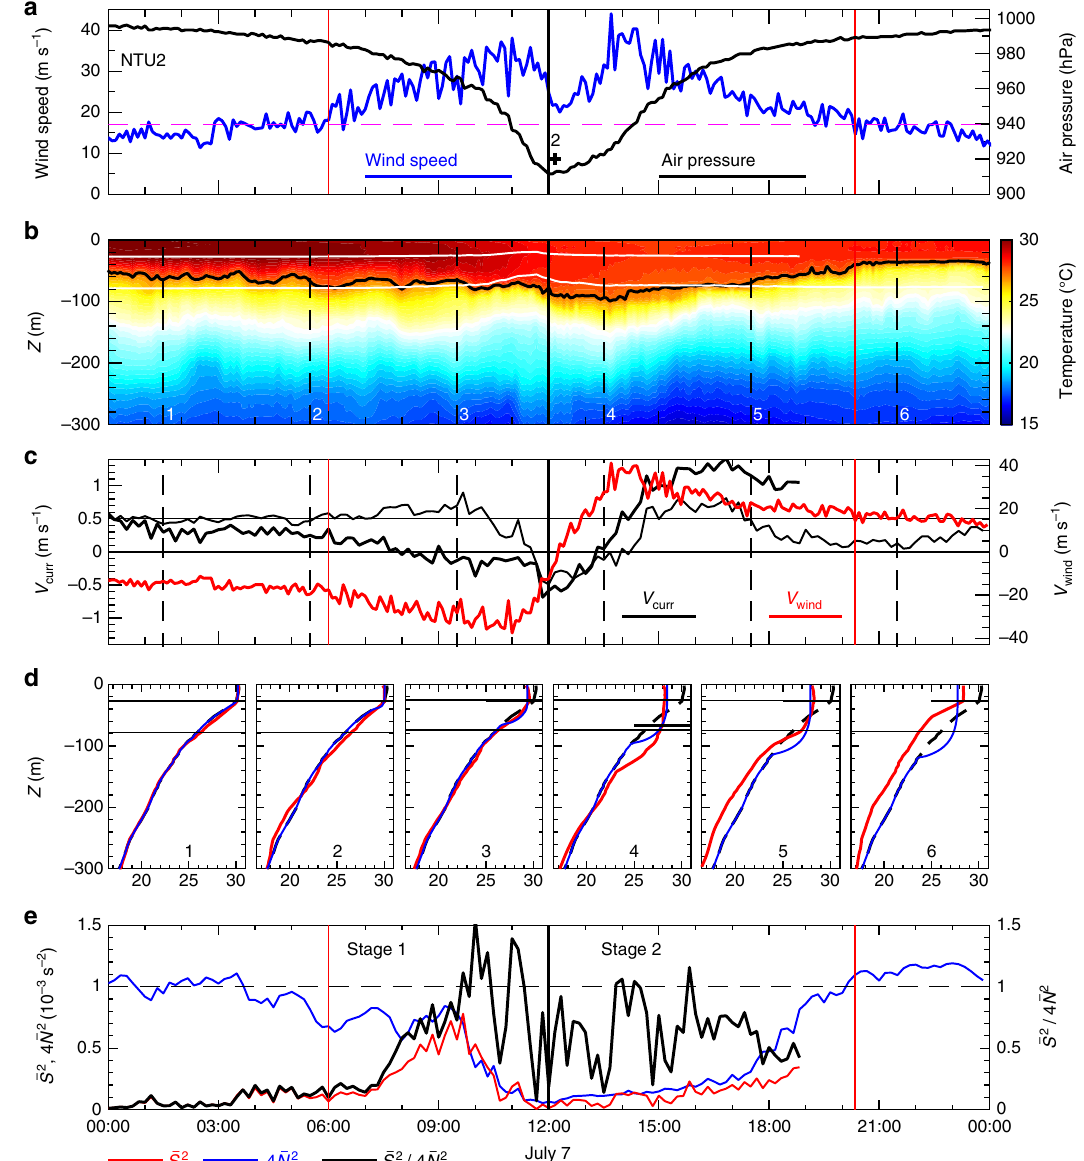
Fig. 2 Buoy NTU2 observations of Nepartak. a Air pressure (black line) and wind speed (blue line); b temperature in the upper 300 m; c meridional current velocity V curr at 25 m (thick black line) and 75 m (thin black line), and meridional wind velocity V wind (red line). The two red vertical lines in a – c mark the beginning (left) and end (right) of the forced period. The black curve in b is the 27.2 °C isotherm. d Observed (red line), simulated (blue line), and pre- storm (black dashed line) temperature pro fi les at times 1 – 6 as indicated by the vertical black dashed lines in b and c . Black lines in d mark the mixed layer depth. The black vertical line in a – c marks the time of minimum sea level pressure. e Velocity shear square (cid:1) S 2 (red line), four times of buoyancy frequency square 4 (cid:1) N 2 (blue line), and (cid:1) S 2 = 4 (cid:1) N 2 (black line). The two white lines in b indicate the depths of the two current meters measured by the pressure sensors of the current (cid:1) (cid:1) S 2 (cid:1) ( = N 2 / S 2 ) < 0.25, which is transformed to > 1 (black curve in 4 (cid:1) N 2 Fig. 2e) as the unstable condition for convenience. The value of (cid:1) S 2 is mostly greater than 1 during the latter half of Stage 1, 4 (cid:1) N 2 thereby suggesting the occurrence of shear instability and (cid:1) S 2 associated turbulent mixing; whereas, during Stage 2, is 4 (cid:1) N 2 rarely beyond the unstable condition. Our inference for the typhoon wind-induced shear instability being the primary dynamic of the rapid temperature drop during the forced period of Nepartak was examined using the one-dimensional Price, Weller, and Pinkel (PWP) model 21 , which is discussed later in this study.